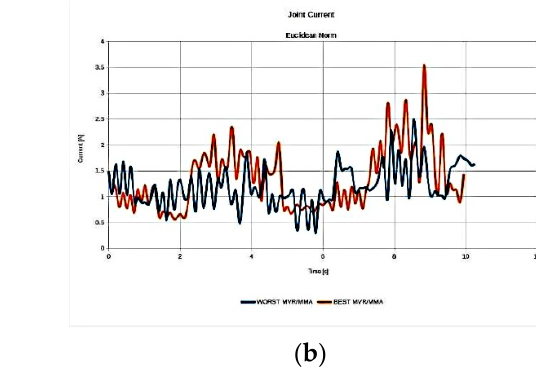
Figure 25. Comparison of the required joint velocities ( a ) and joint current usage ( b ) for the best anatomy and the worst performing anatomy under the MMA and MVR performance index for Task 4.